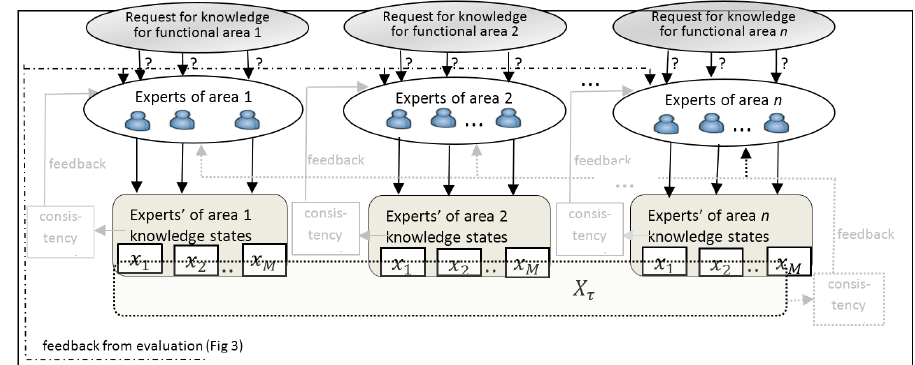
Fig. 1. Acquiring and acquisition of a collective knowledge of business